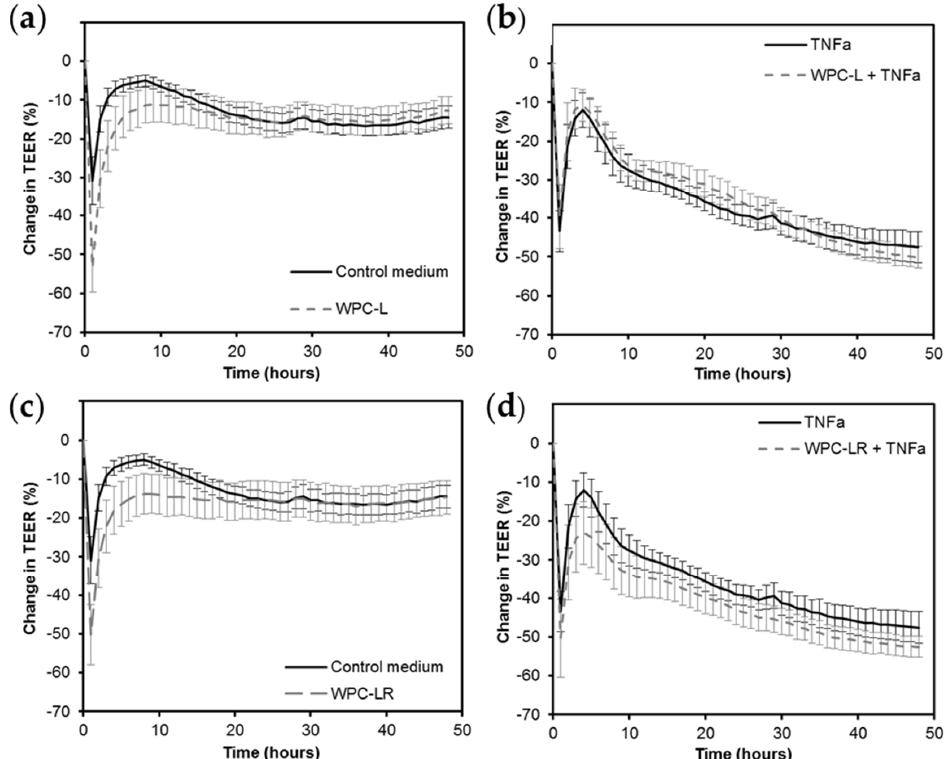
Figure 2. Effect of WPC on the trans-epithelial electrical resistance (TEER) across Caco-2 cell monolayers, ( a , c ) under normal conditions, and ( b , d ) challenged with tumor necrosis factor alpha (TNF α ) for WPC-L and WPC-LR. The values shown at the % change in TEER compared to the initial TEER for each insert. The data from three independent assays, each with four replicates per treatment, were combined (total n = 12 per treatment) to calculate the mean ± SEM. There were no significant differences between treatment groups and their respective controls.